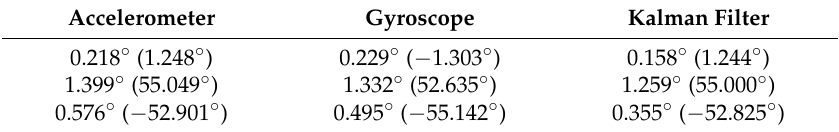
Table 2. Comparison of the standard deviation (and mean value) of the tag roll measurements.